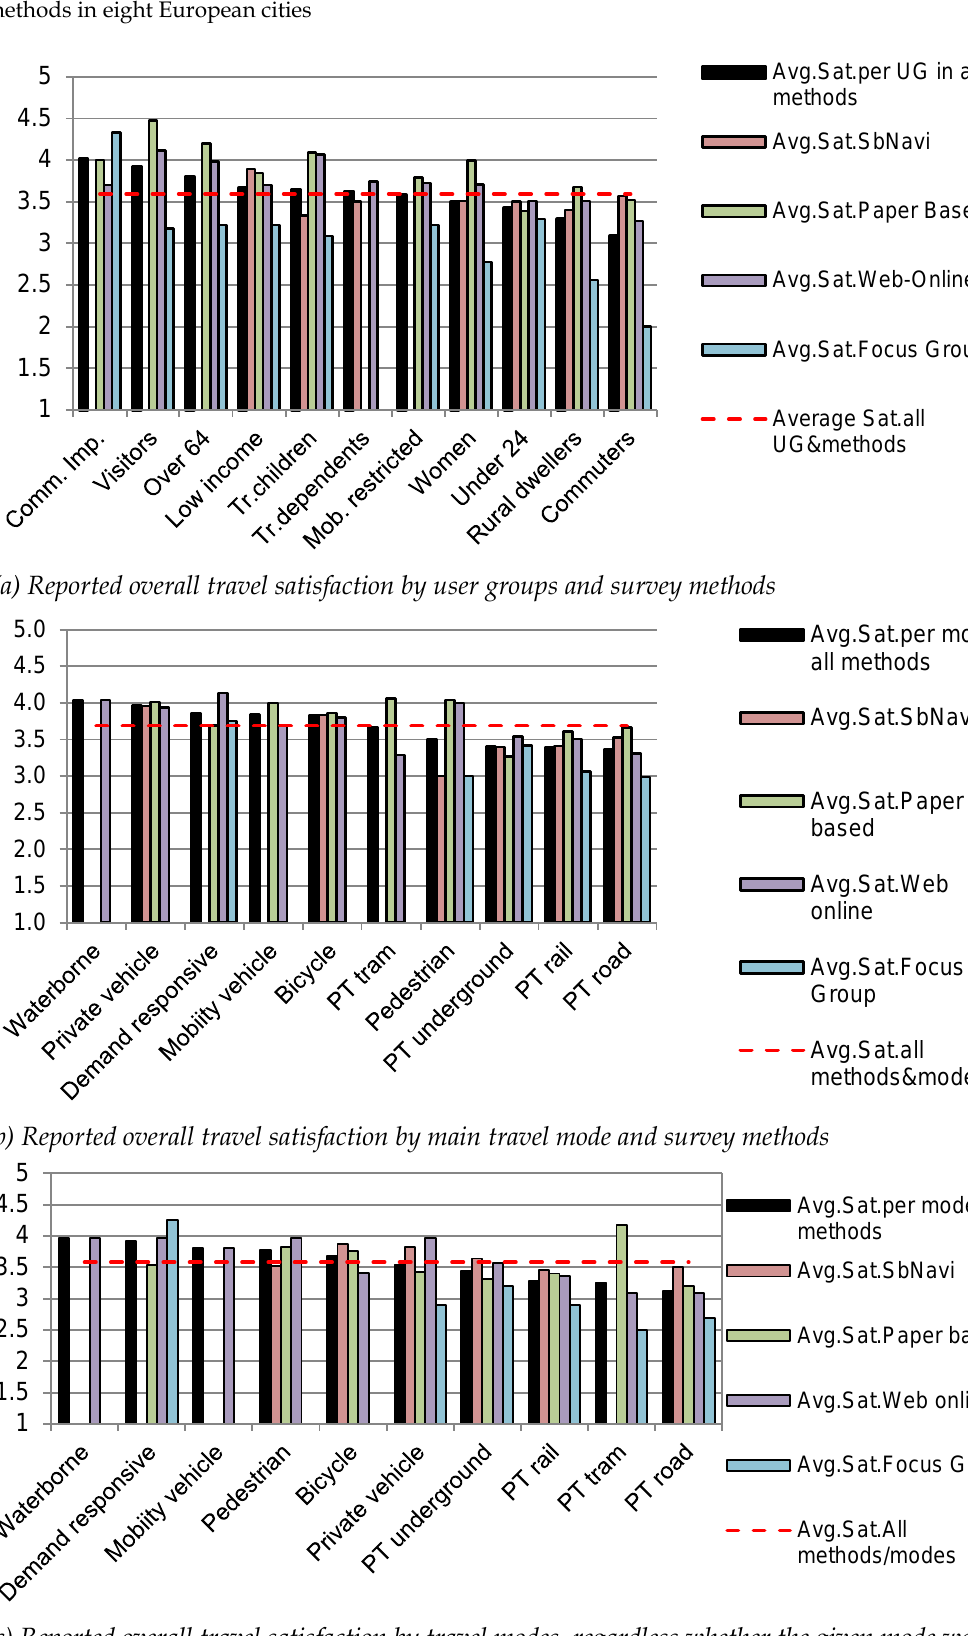
Figure 3. Overall travel satisfaction by user groups, travel modes and survey